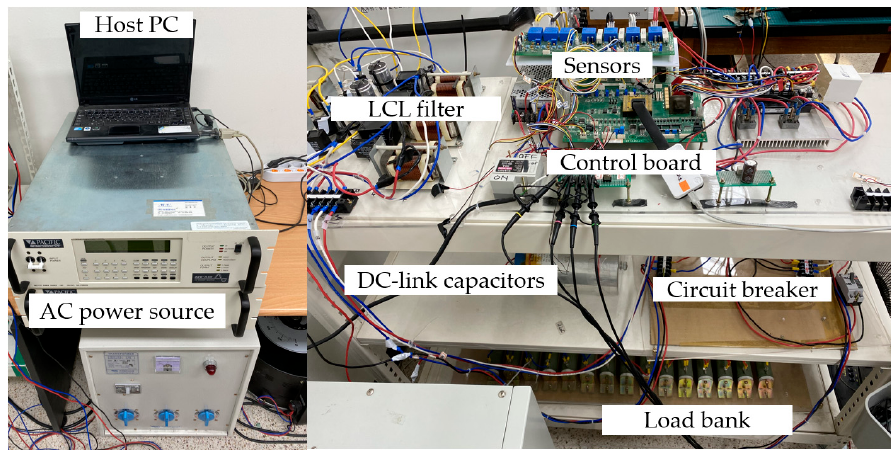
Figure 15. Configuration of hardware system.